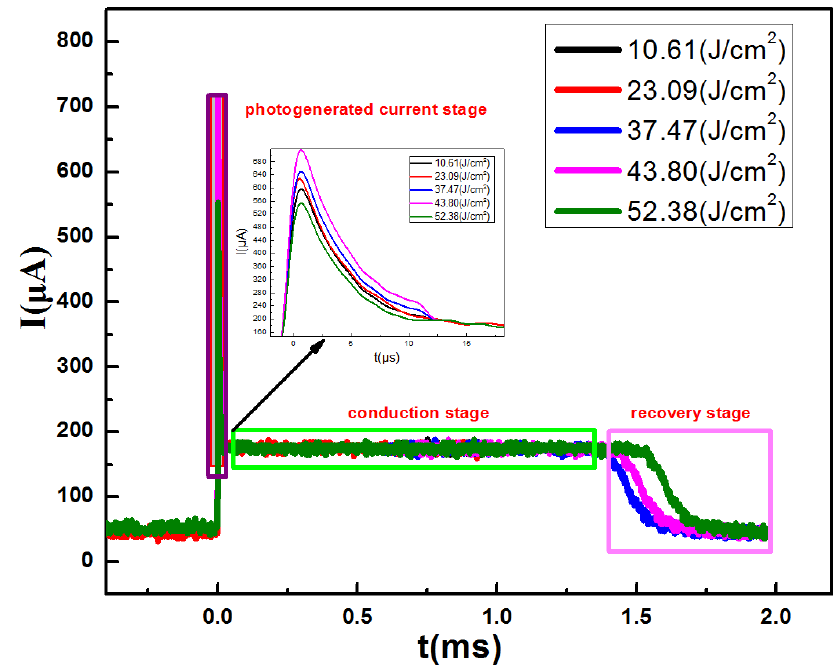
Figure 3. The time-varying diagram of a 1-ms pulse width and 180-V bias voltage at the different energy densities between the sampling current.